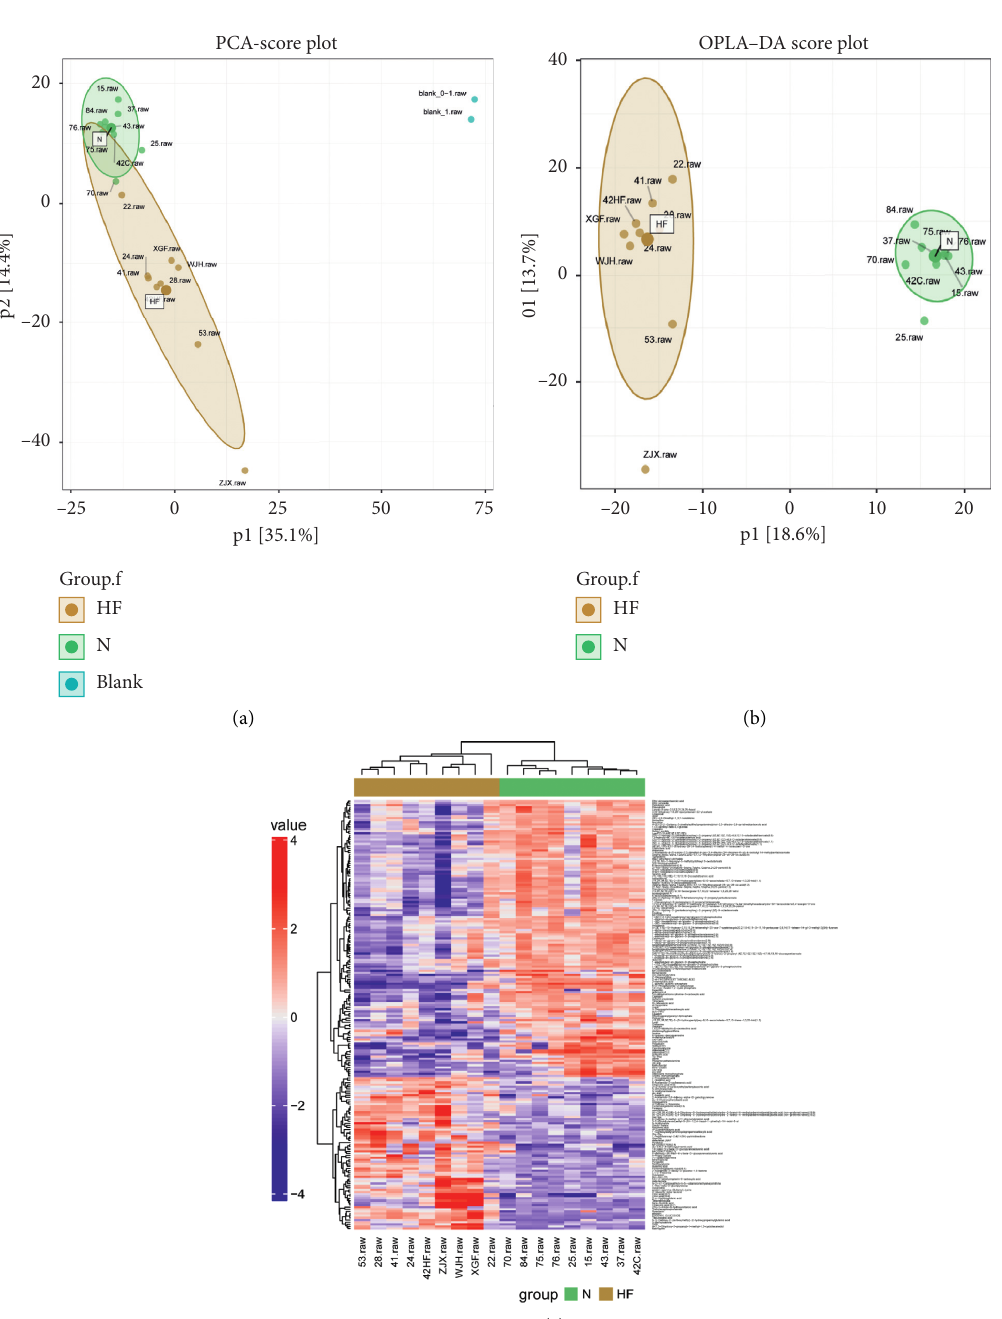
Figure 3: Plasma samples were obtained from HF patients and healthy controls to identify differential metabolomic characteristics by LC- MS. (a) Scatter plot of the PCA model for the HF group versus the healthy group. (b) Scatter plot of the OPLS-DA model for the HF group versus the healthy group. (c) Clustering heat map of the samples. The rows and columns represent metabolites and samples, respectively. LC- MS: Liquid chromatograph tandem mass spectrometry; HF: Heart failure; PCA: Principal component analysis; OPLS-DA: Orthogonal partial least-squares discriminant